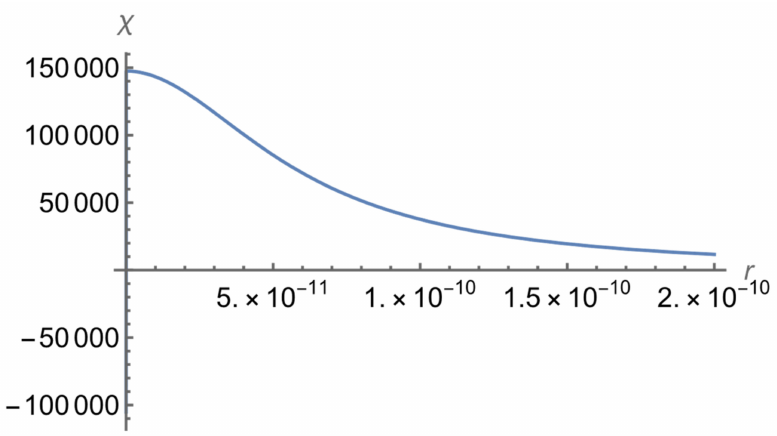
Figure 4. The normalized wave function of the bound E = 0 state of the neutron–neutron system for L = 3 at a relatively large